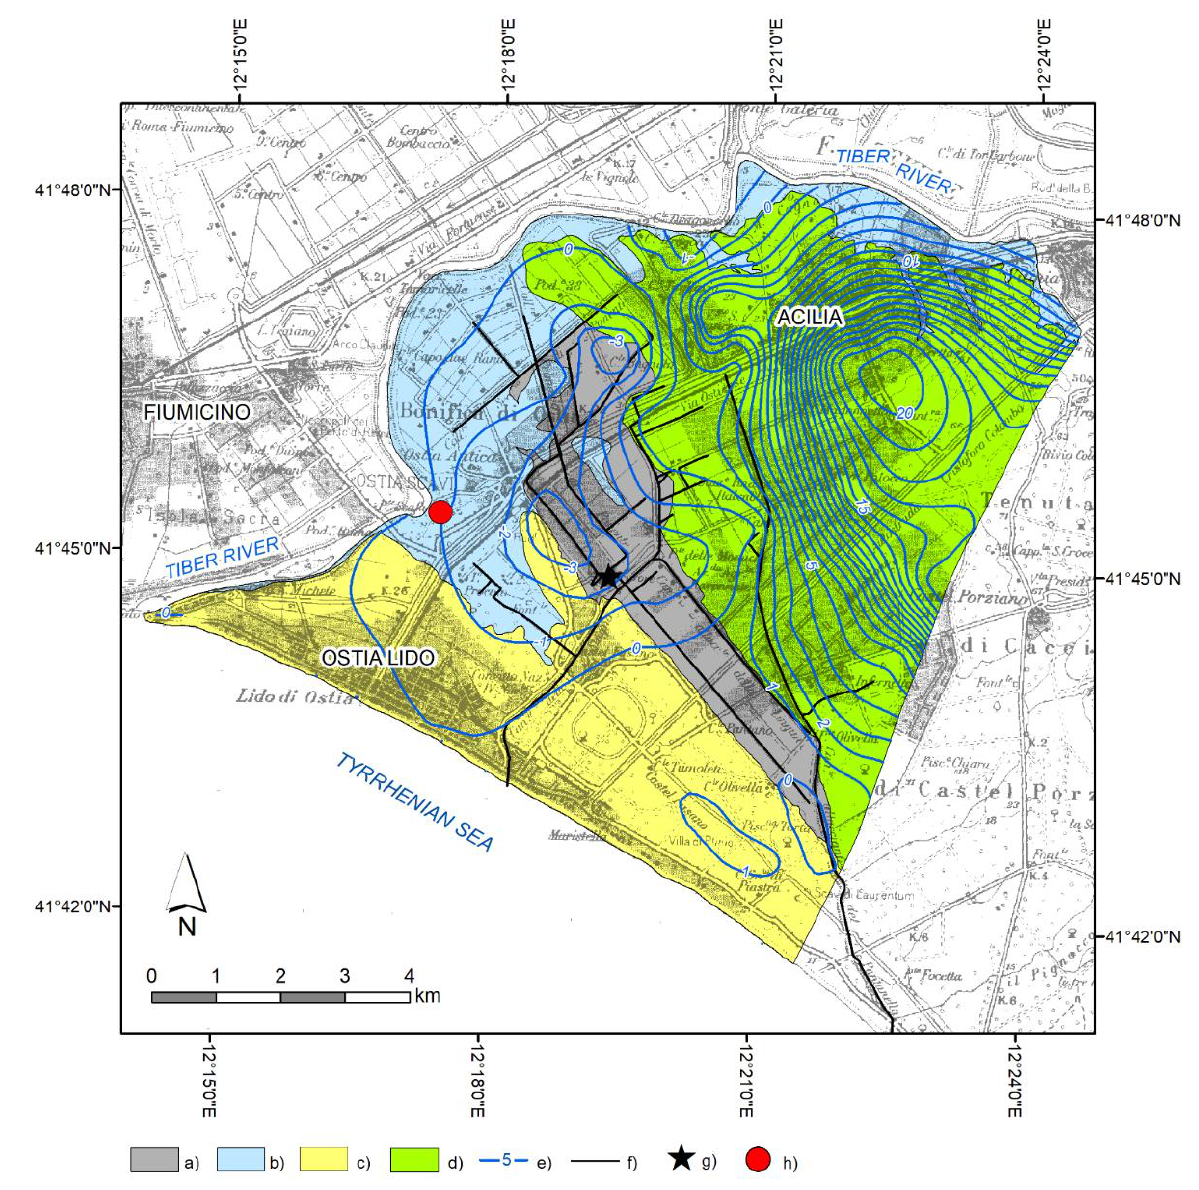
Figure 2. Hydrogeological settings of the left bank of the Tevere River Delta. Legend: ( a ) swamp deposits HOLOCENE; ( b ) sandy, silty and clayey alluvial deposits HOLOCENE; ( c ) sandy beach deposits HOLOCENE; ( d ) heterogeneous clastic deposits (sandy-silt and clay deposits interbedded with gravels) PLEISTOCENE; ( e ) groundwater contour lines (1 m interval); ( f ) reclamation channels; ( g ) Ostia pumping station; ( h ) study area (modified from [32]).